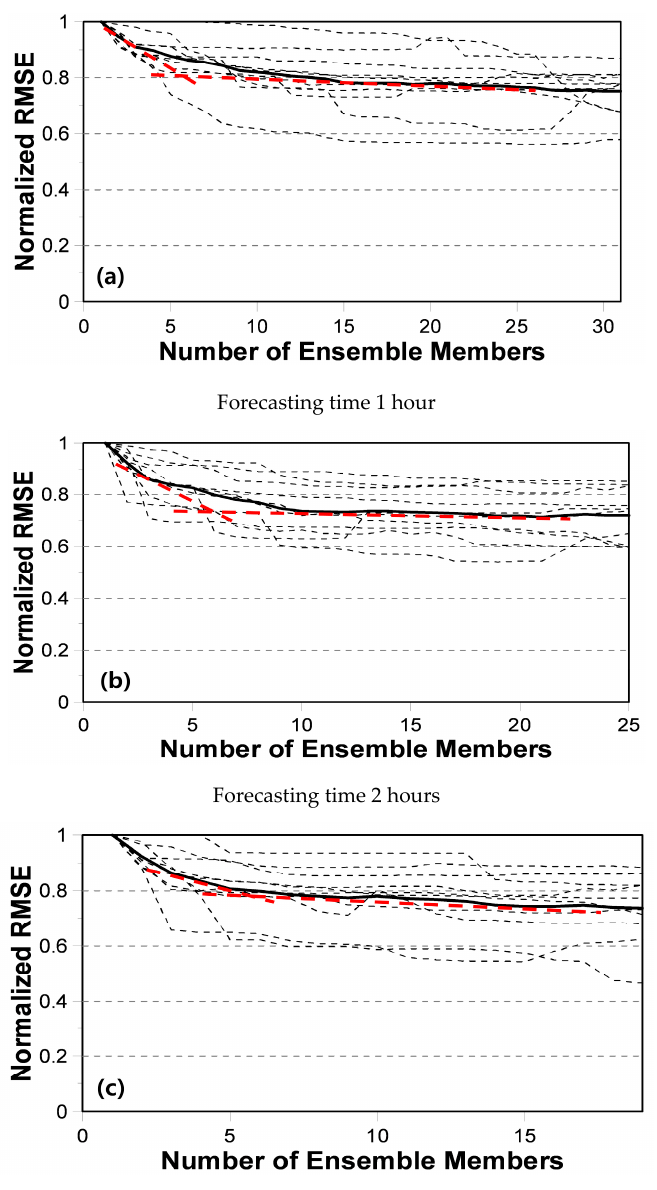
Figure 6. Behavior of the RMSEs (root mean square errors) estimated for the 10 target times and their